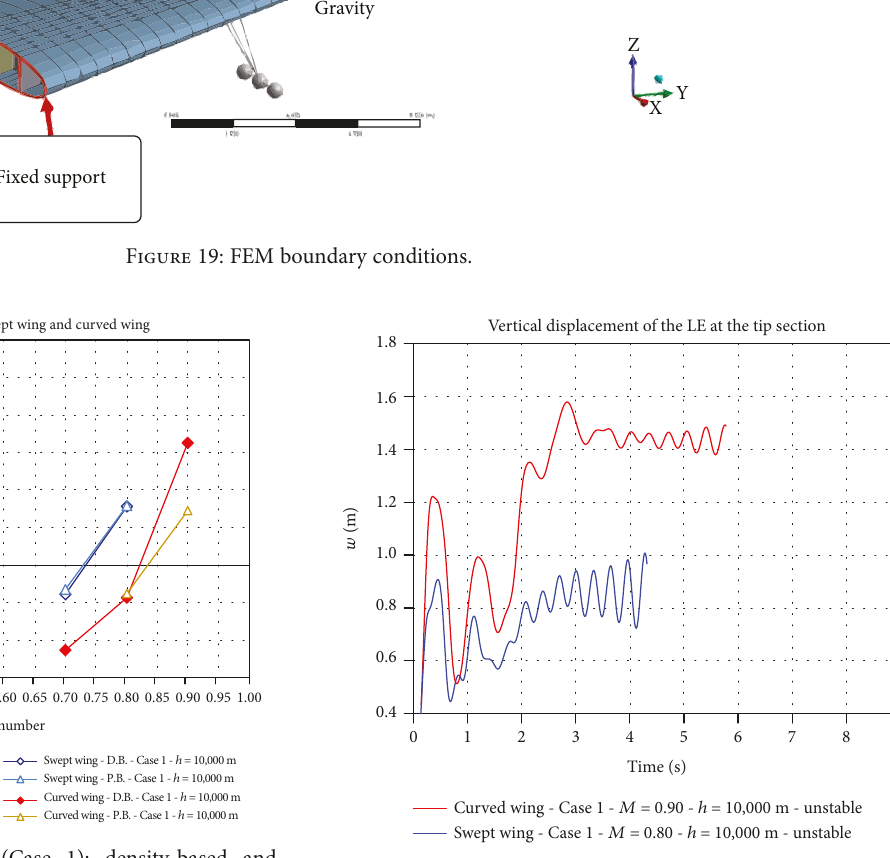
Figure 21: FSI DB — displacement histories at the leading edge of wing tips (Case 1